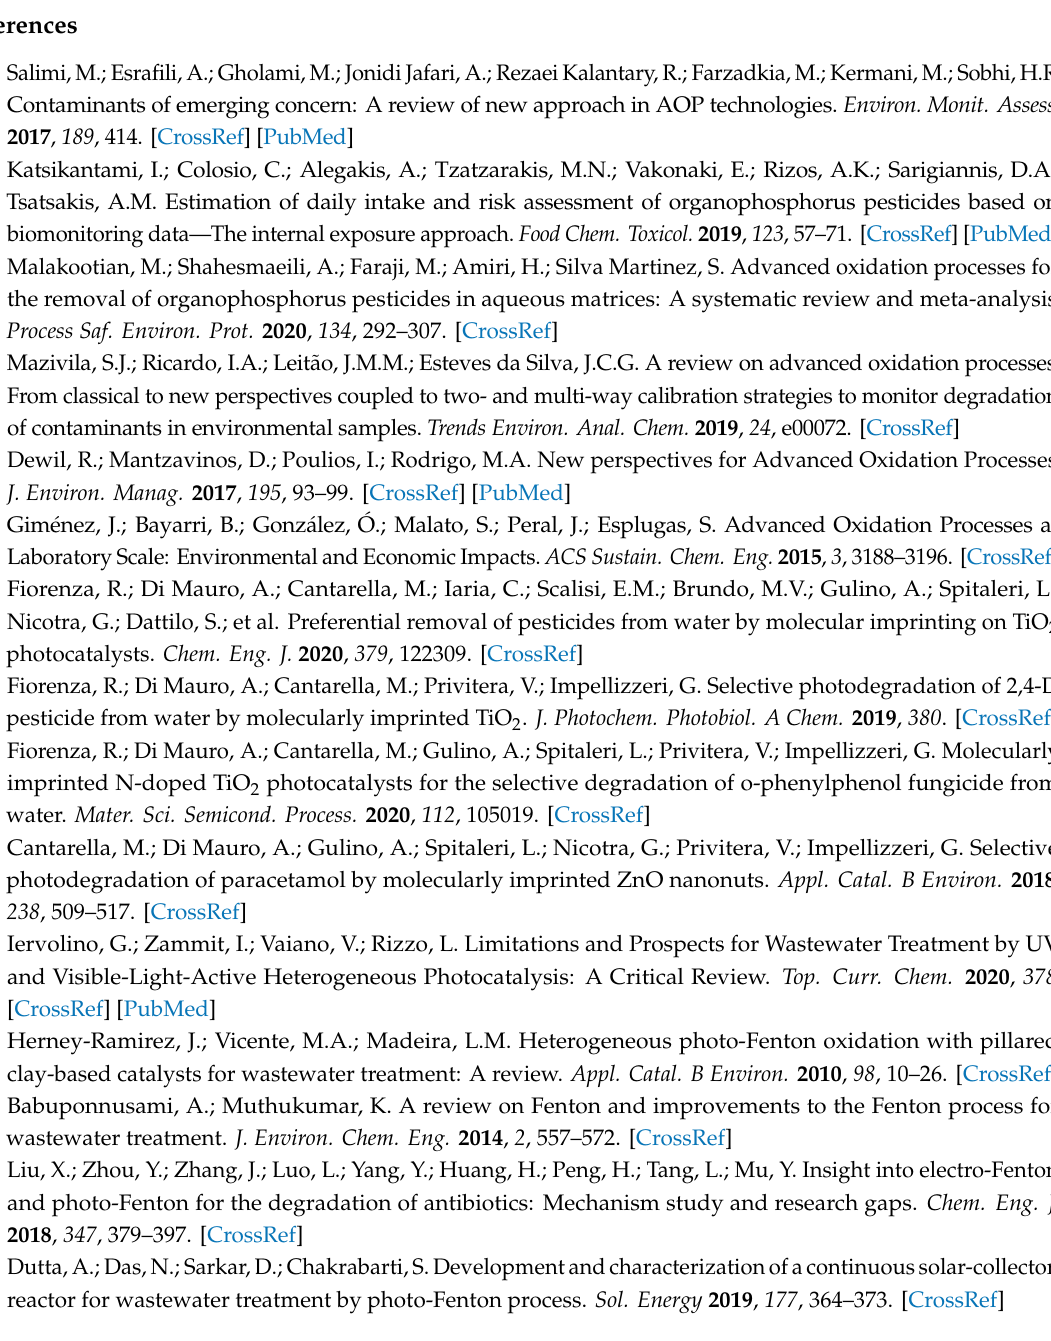
Figure S1: Influence of the H 2 O 2